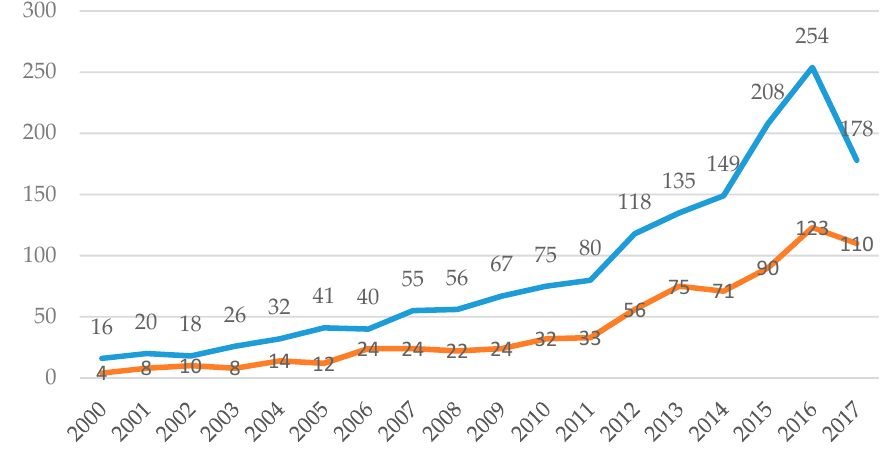
Figure 2. The number of articles on impact of transportation infrastructure.